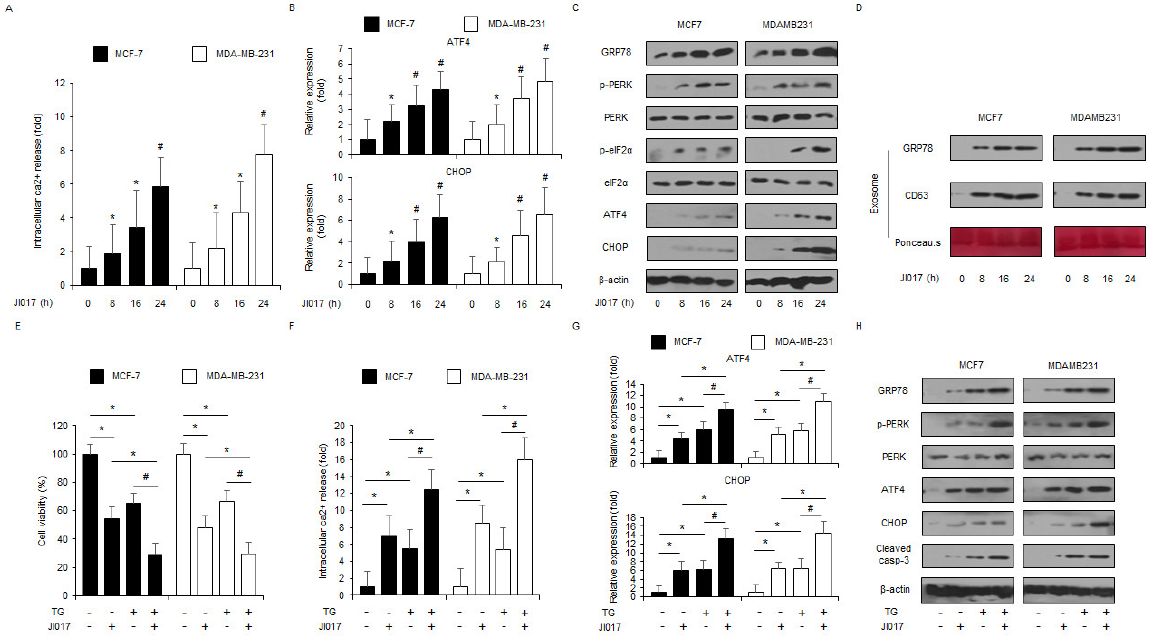
Figure 2. JI017 induces ER stress and cell death via intracellular Ca 2+ release. ( A ) MCF-7 and MDA-MB-231 cells were treated with JI017 (300 µg/mL) in a time-dependent manner (0, 8, 16, and 24 h) and intracellular Ca 2+ release was determined using intracellular Ca 2+ assay; *, p < 0.05, #, p < 0.01. ( B ) MCF-7 and MDA-MB-231 were treated with JI017 (300 µg/mL) in a time-dependent manner (0, 8, 16, and 24 h) and mRNA levels of ATF4 and CHOP were investigated using real-time RT-PCR; *, p < 0.05, #, p < 0.01. ( C ) MCF-7 and MDA-MB-231 cells were treated with JI017 (300 µg/mL) for the indicated times (0, 8, 16, and 24 h) and the activation of ER stress signaling, including GRP78, p-PERK, PERK, p-eIF2α, eIF2α, ATF4, and CHOP, was assessed using the Western blot assay. β-actin was used as a protein loading control. ( D ) MCF-7 and MDA-MB-231 cells were treated with JI017 (300 µg/mL) for the indicated times (0, 8, 16, and 24 h) and exosomes were extracted from the cell culture media. Protein samples extracted from cell lysates and exosomes was quantified by Ponceau S staining. These samples were conducted by Western blotting using the ER stress marker, GRP78 and the exo- some marker, CD63. ( E – H ) Real-time RT-PCR of ATF4 and CHOP and Western blotting of GRP78, p-PERK, PERK, ATF4, CHOP, and cleaved caspase-3 levels were determined using WST-1 assay and intracellular Ca 2+ assay in thapsigargin (TG; 3 µM, 24 h) and JI017 (300 µg/mL, 24 h)-treated breast cancer cells; *, p < 0.05, #, p < 0.01. 3.3. Targeting ER Stress Suppresses JI017-Mediated Cell Death in Breast Cancer Cells To confirm whether JI017 treatment regulates the ER stress master regulator GRP78, GRP78-specific siRNAs were transfected into MCF-7 and MDA-MB-231 cells, which were then treated with JI017. In a knockdown experiment, GRP78 siRNAs blocked the decrease in cell viability and increase in LDH production, Ca 2+ production, and caspase-3 activity to a greater extent in JI017-treated MCF-7 and MDA-MB-231 cells (Figure 3A,B). Western